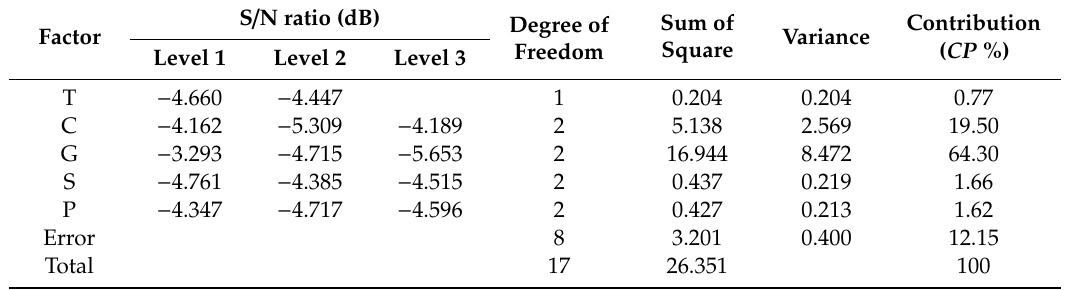
Table 7. Results of the ANOVA for the GRG for the wire-saw machining of slicing ceramic (SC). S / N ratio (dB) Degree of Factor